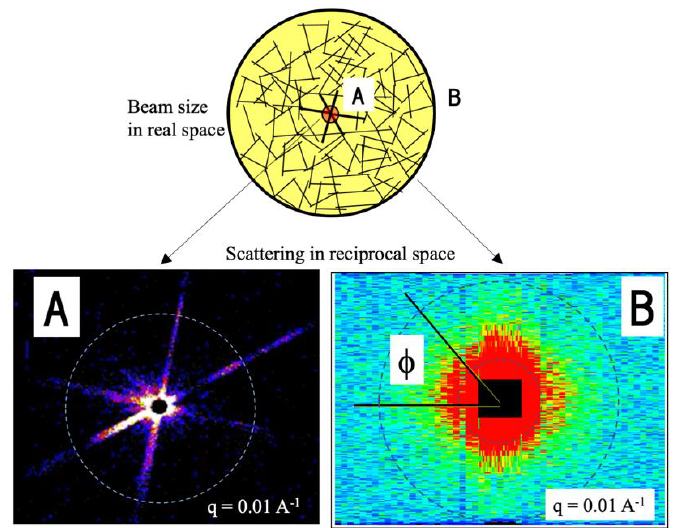
Figure 10. Two-dimensional small-angle scattering patterns appeared in an x–y plane of the large area detector. In the case of X-ray scattering ( A ), an incident beam with a 0.5 mm diameter was used, so individual foam films caused streak scattering patterns, which were parallel to the normal vector of the foam film. In case of neutron scattering ( B ) with a beam with a 10 mm diameter, an isotropic scattering pattern appeared on the detector.